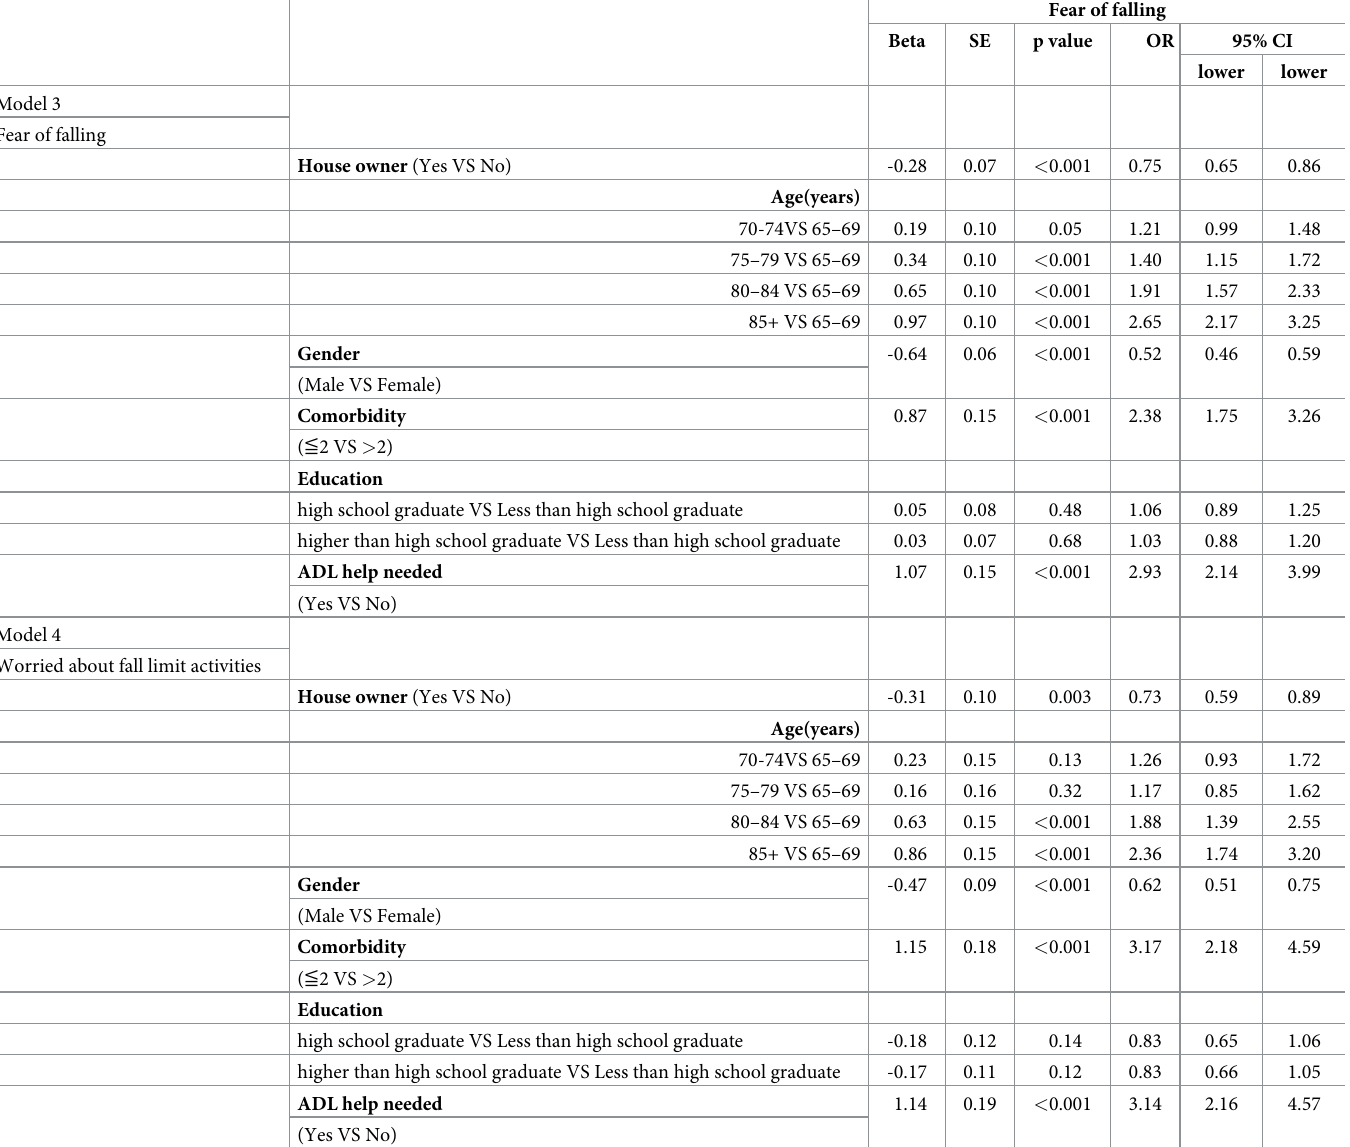
Table 4. Multiple logistic regression model of house owner related to fear of